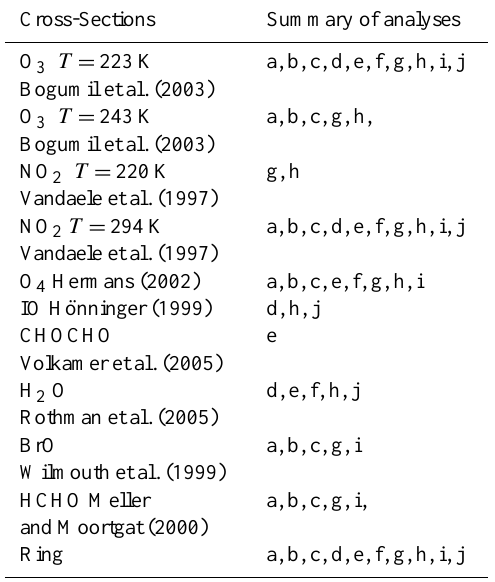
Table 4. Summary of the cross-sections used for each of the differ- ent analysis settings during this study.